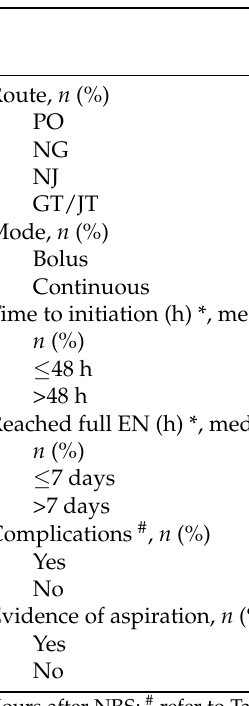
Table 3. Nutrition Details for Non-Intubated EN Group ( n =